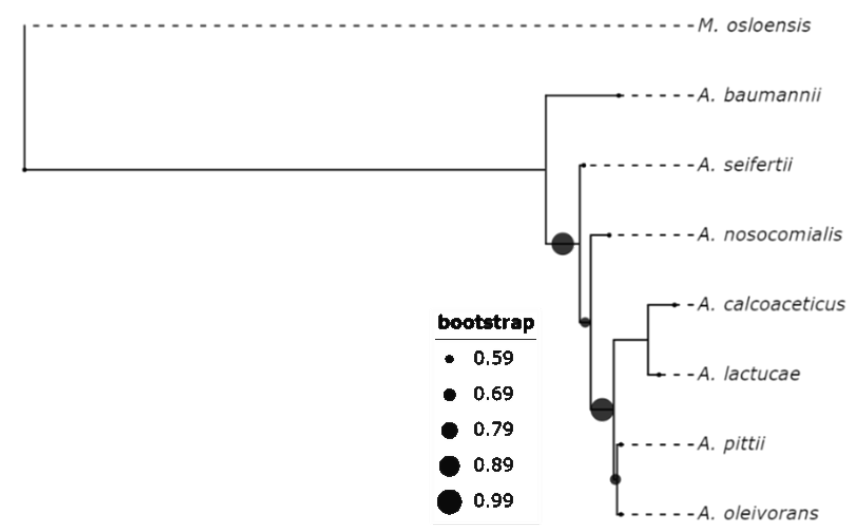
Figure 1. Phylogenetic analysis of the Acb complex. The phylogeny tree was inferred with MEGA X on a Clustal W alignment of the 16S rRNA in the selected type strains. The maximum likelihood- kimura 2-parameter (ML-K2) model was used. Moraxella osloensis was chosen as an outgroup. Strain names and their corresponding GenBank accession numbers are listed in Table S1, Supplementary Materials. A. oleivorans has also been catalogued into the Acb group in some studies [21–23], though its name has not yet been validated.